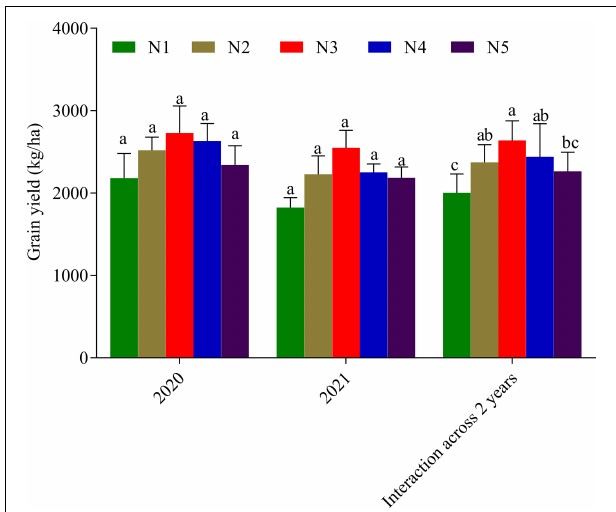
FIGURE 3 | Yield of wheat cultivar fertilized with 0 kg N ha − 1 (N1), 52.5 kg N ha − 1 (N2), 105 kg N ha − 1 (N3), 157 kg N ha - 1 (N4), and 210 kg N ha − 1 (N5). Bars in year/interaction across 2 years with the same/a common alphabet indicates no significant difference with Duncan Multiple Range Test at 5% probability level and those with different alphabets mean otherwise. Error bars indicate the standard